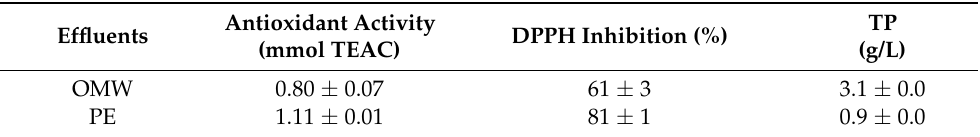
Table 4. Effluents: Antioxidant activity and total phenolic